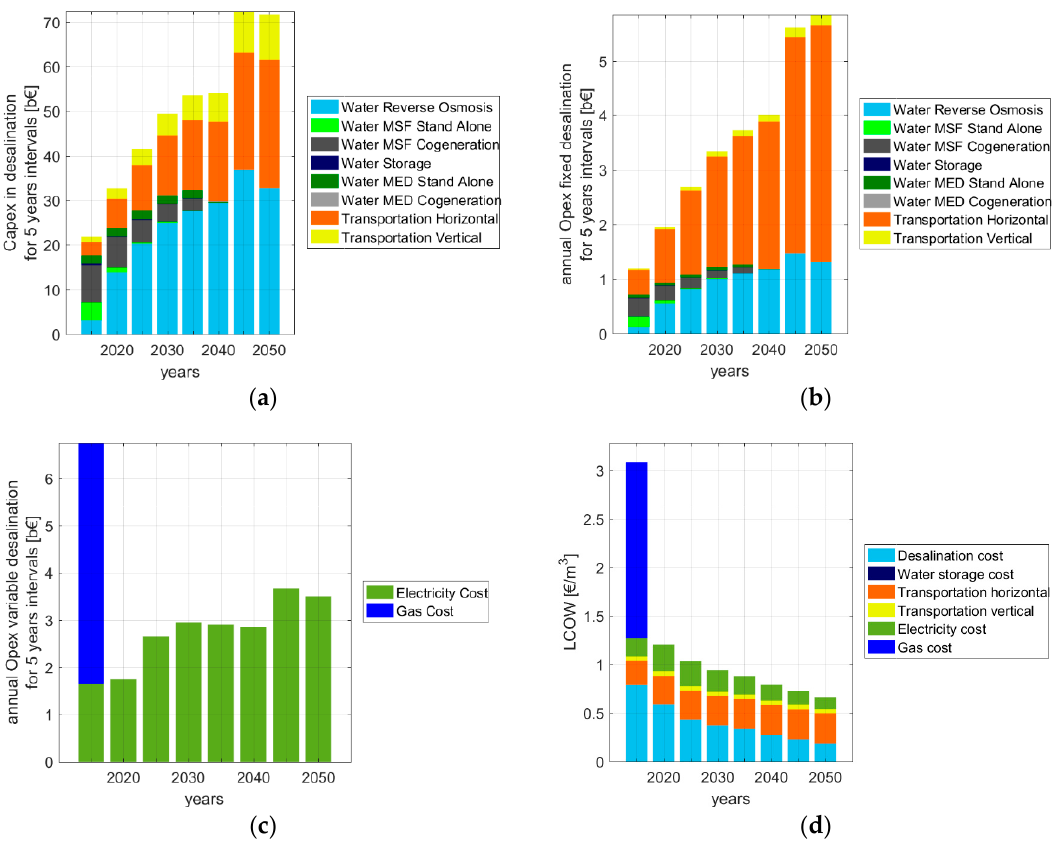
Figure 15. Capex of all desalination sector components ( a ), annual fixed opex for desalination sector components ( b ), annual variable opex for desalination sector components ( c ) and LCOW variation ( d ) from 2015 to 2030.